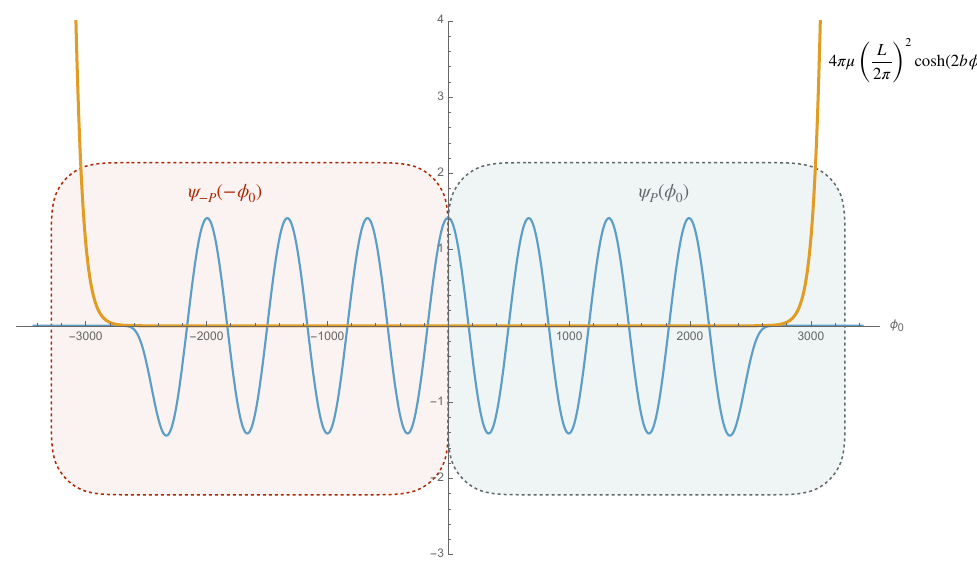
Figure 2 . The sinh-Gordon potential and the corresponding wave-function. In the two colored regions, we can approximate the wave-function by the corresponding Liouville one. In the middle region, they reduce to plane waves and requiring their compatibility enforces the quantization condition